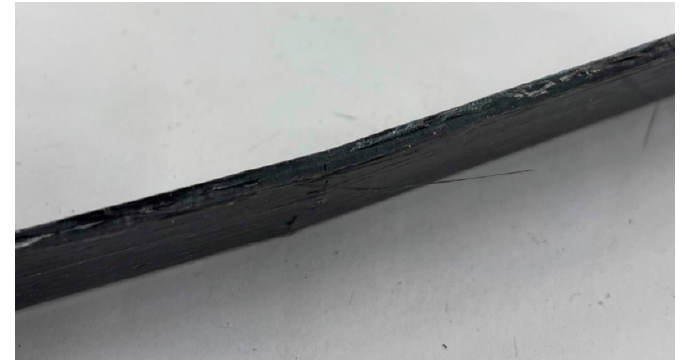
Figure 11. Failed flexural